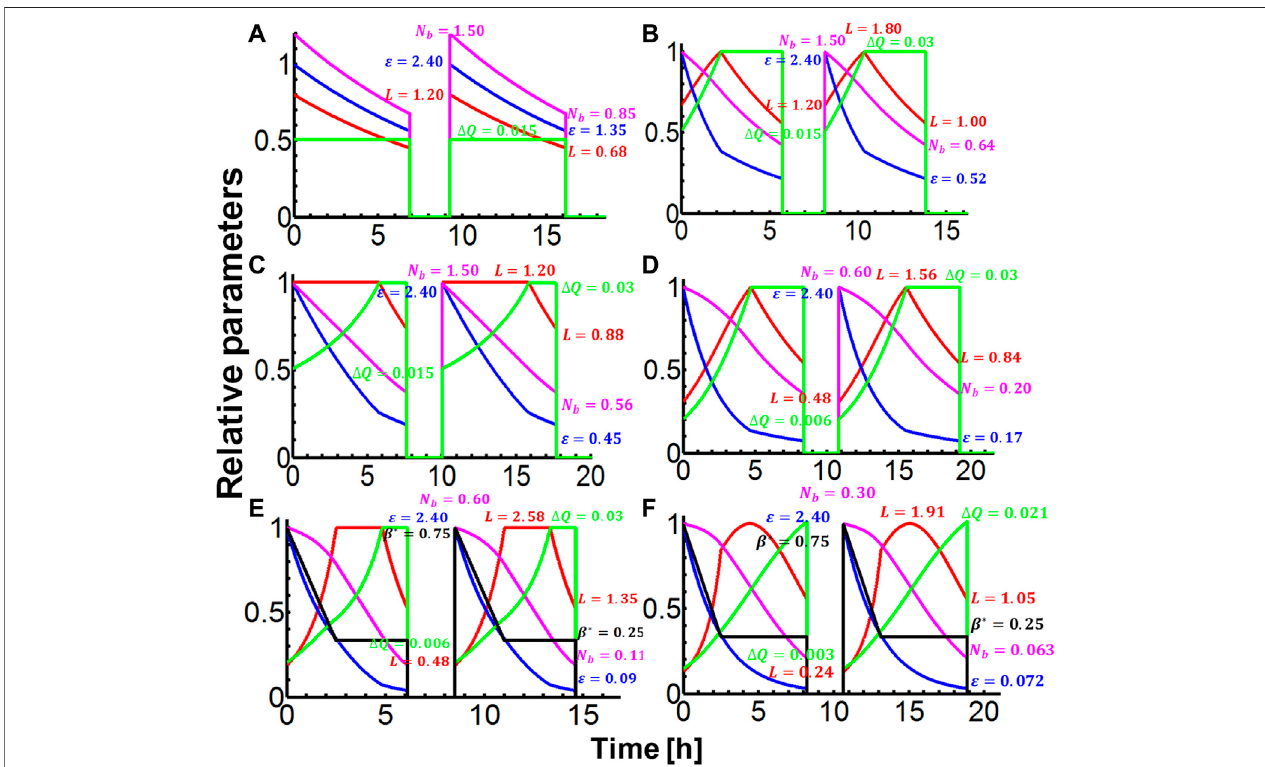
FIGURE2| Evolutionofparametersvs. timewithaturnaroundtimeof2.4 handbunchspacingof25 ns.Red: luminosity,magenta:numberofprotonsperbunch, blue:transverseemittance,green:beam-beamtuneshift,black:beta*attheIP. (A) with fi xedtuneshift; (B) allowingthetuneshifttoriseto0.03; (C) asin (B) butwiththe luminosity “ leveled ” atitsinitialvalue; (D) asin (C) butbunchspacingof10 ns; (E) asfor (D) butreducingbeta*inproportiontoemittancedownto25 cm; (F) asfor (E) but with bunch spacing of 5 ns. In plots (A) , (B) , (C) and (D) , beta* is kept constant at the nominal 0.75 m.